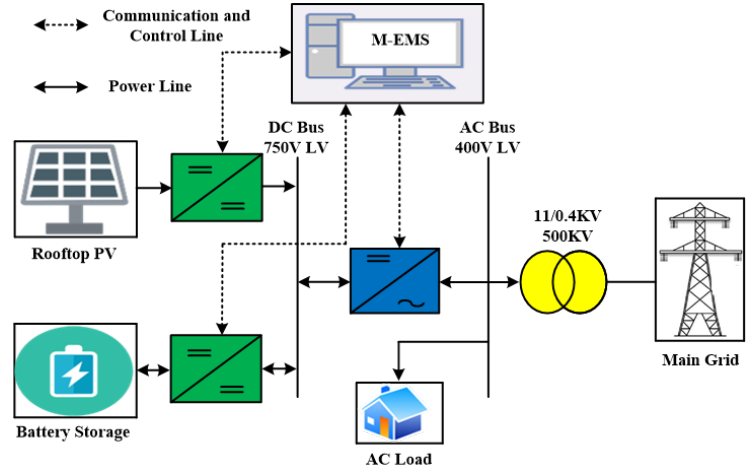
Figure 1. Structure of the understudy